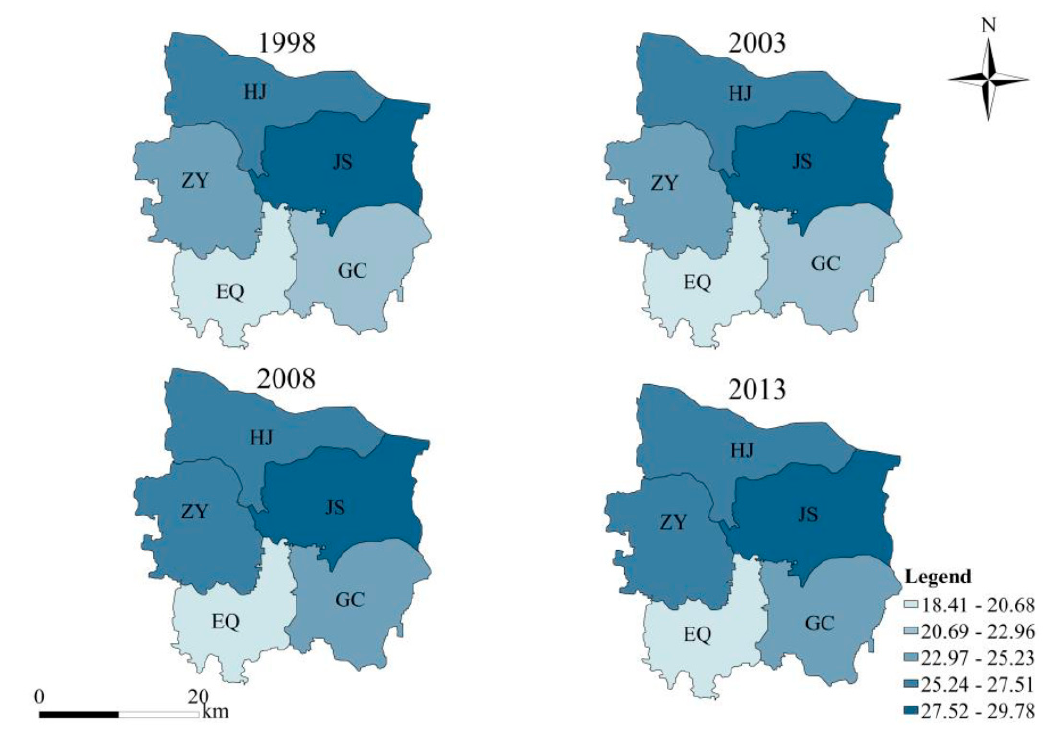
Figure 11. Runoff from SCS model in different regions in different periods (10 6 m 3 ). Figure 11. Runo ff from SCS model in di ff erent regions in di ff erent periods (10 6 m 3